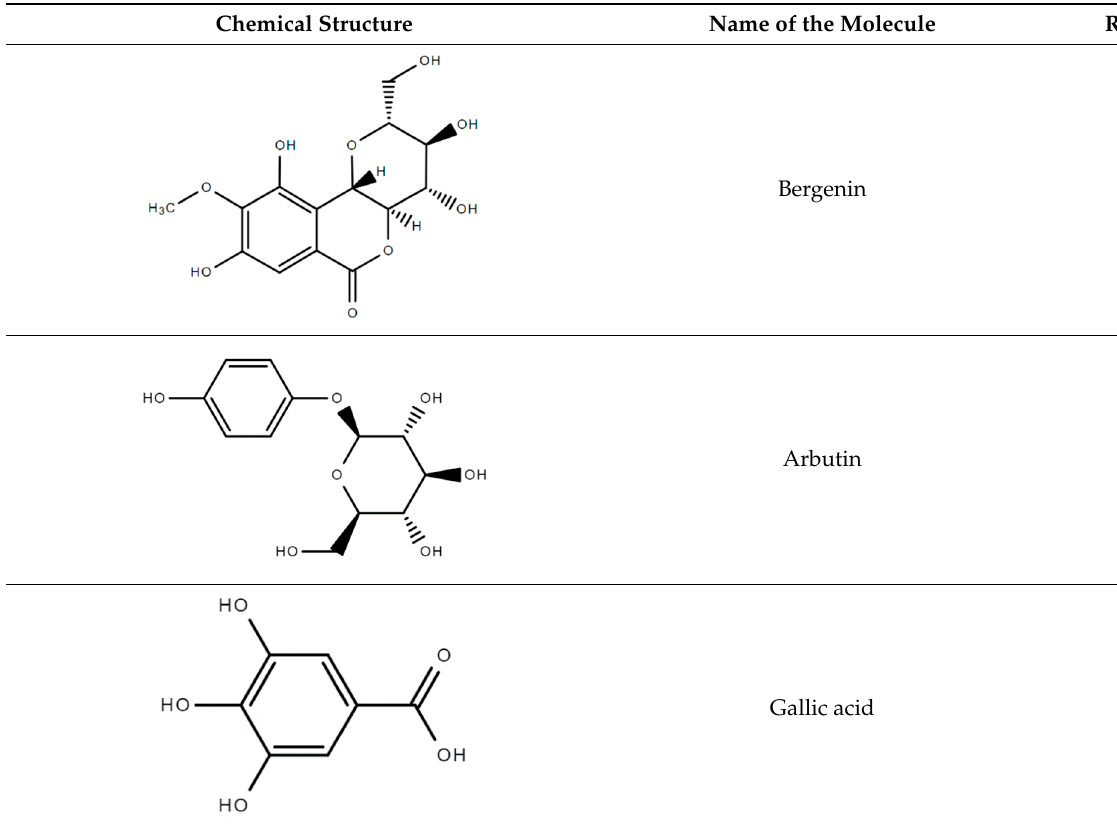
Table 1. Bioactive molecules found in Bergenia ligulata .